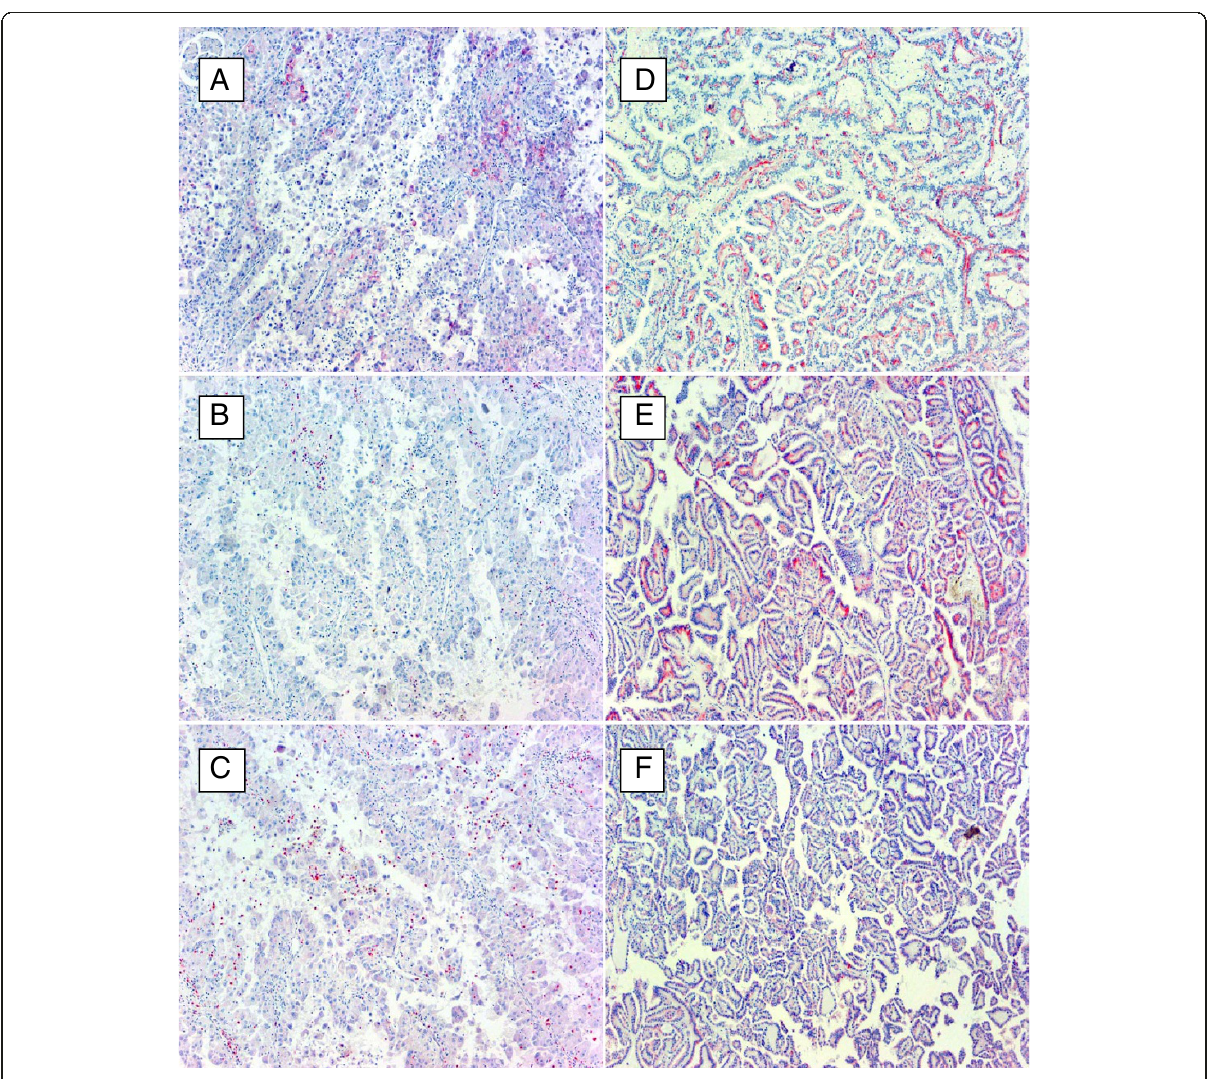
Figure 2 Histopathological evaluation of cadherin expression in both sybtypes of papillary RCC. N-cadherin showed a significant difference in membranous and cytoplasmic expression between both subtypes of papillary RCC. A significant difference for E-, P- and KSP- cadherin expression could not be